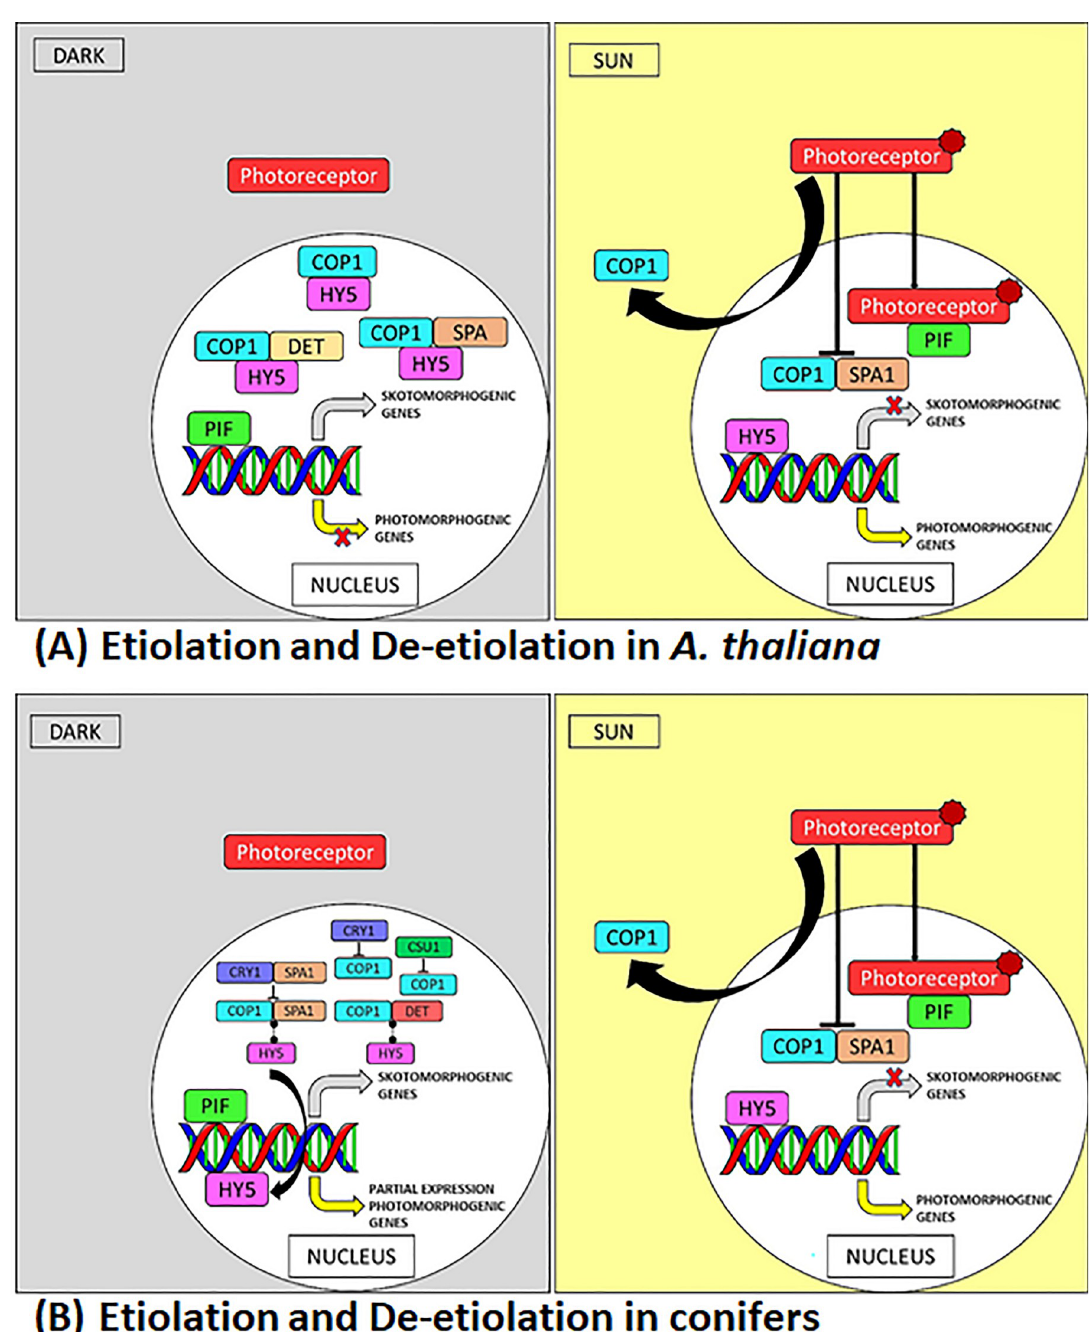
Fig 5. Comparison of the process of etiolation and de-etiolation in A . thaliana and conifers. (A) Etiolation and de-etiolation in A . thaliana (B) Proposed mechanism for etiolation and de-etiolation in